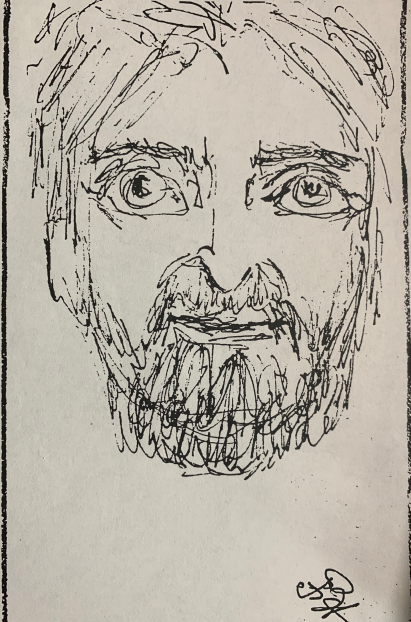
Figure 2: A self-portrait of Frank